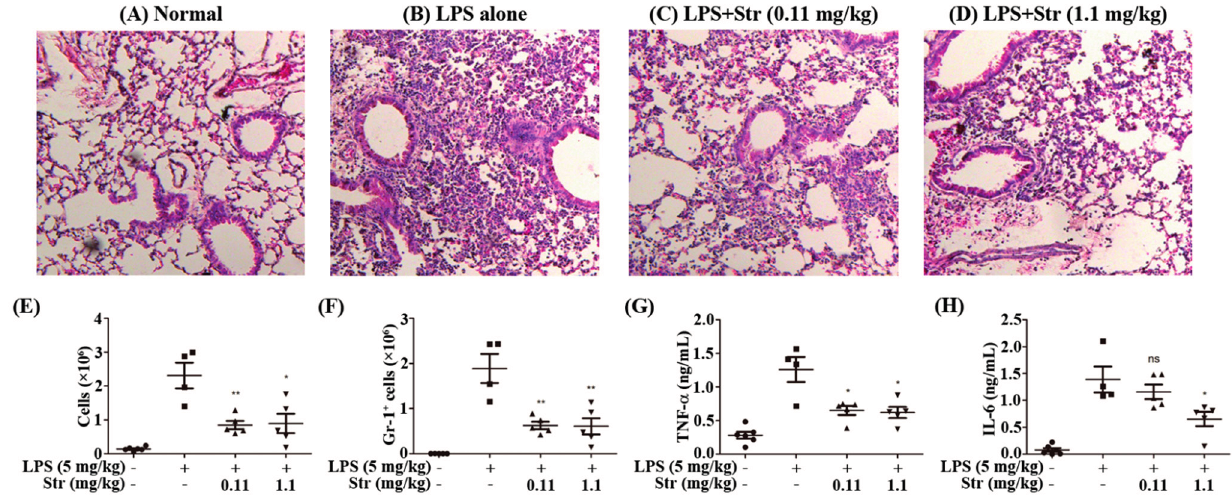
Figure 2. Effects of streptochlorin on LPS-induced ALI mouse model. BALB/c mice